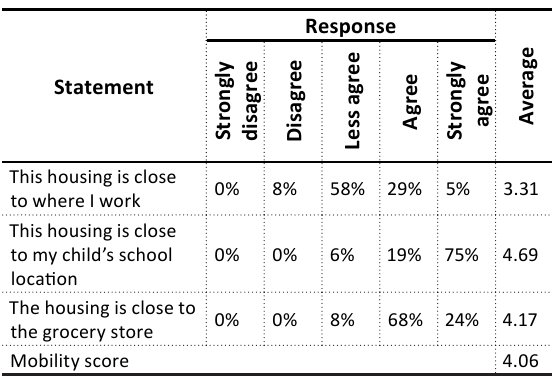
Table 4. Mobility construct descriptive statistics